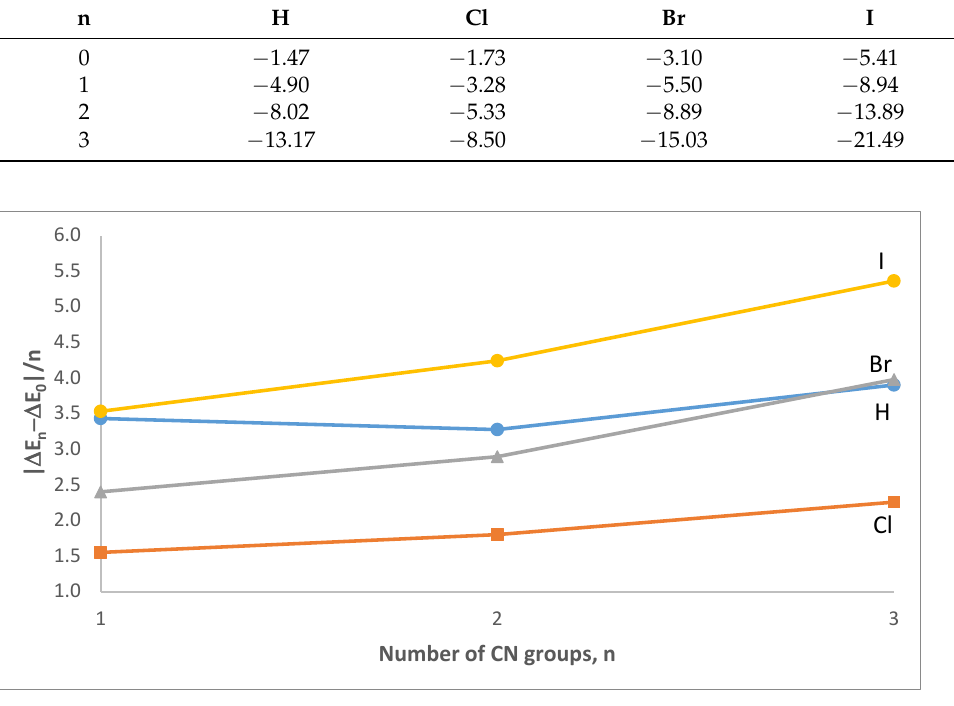
Figure 6. Changes in the magnitude of the interaction energy per CN group added in the CH 3-n (CN) n X∙∙∙NMe 3 (X = H, Cl, Br, or I; n = 0–3) dimer complexes. Values calculated at MP2//ωB97X-D/aug-cc-pVTZ level of theory.